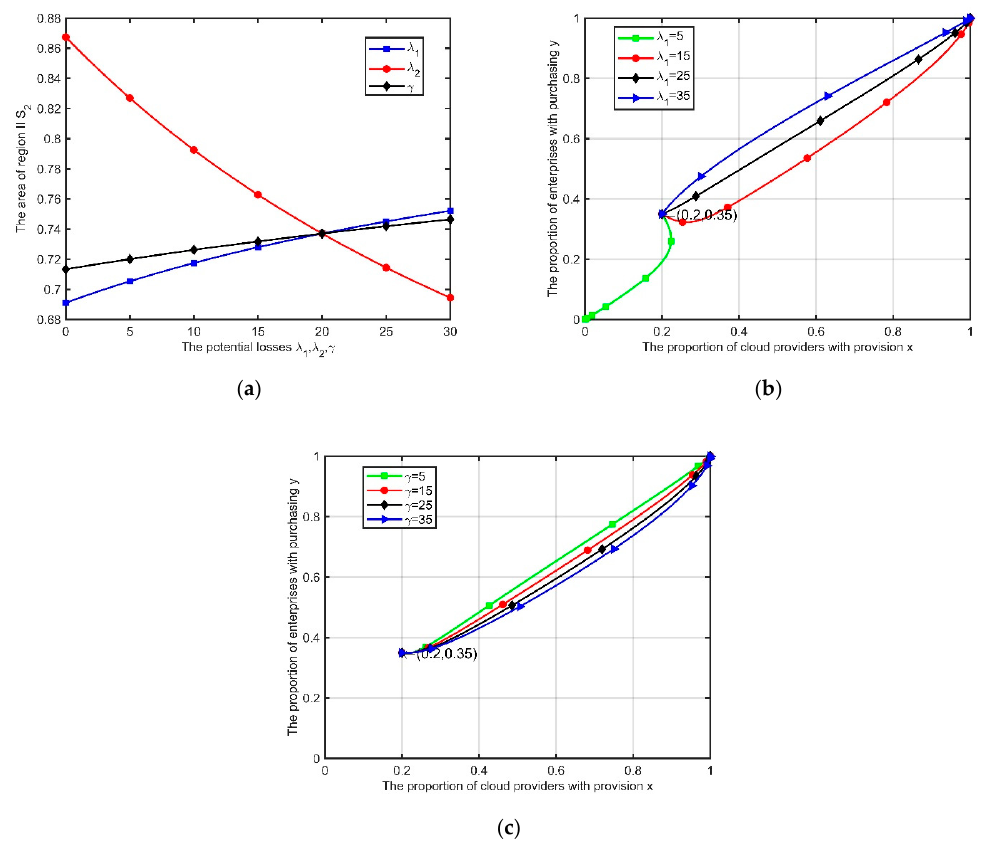
Figure 11. The impact of λ 1 , λ 2 , and γ on S II and evolutionary paths ( a ) The impact of λ 1 , λ 2 , and γ on S II ; ( b ) The evolutionary paths with different potential losses λ 1 ; ( c ) The evolutionary paths with different potential losses γ .